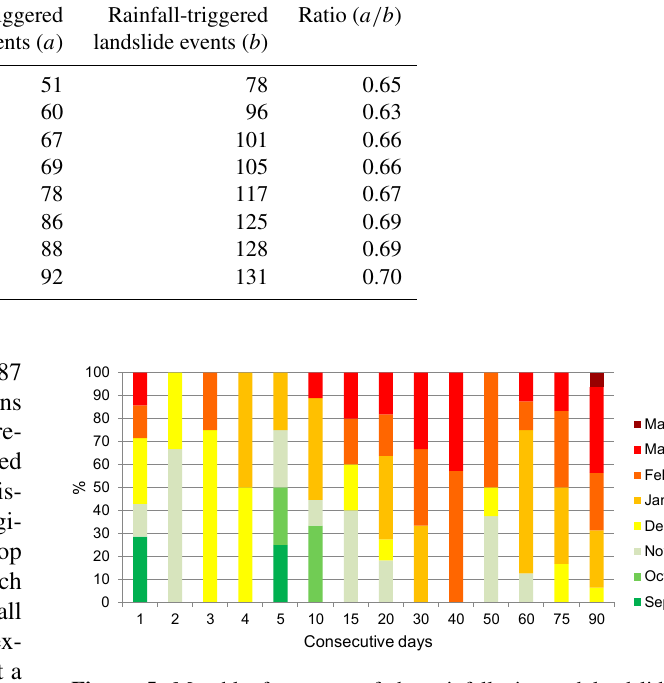
Figure 5. Monthly frequency of the rainfall-triggered landslide events against the duration of the rainfall